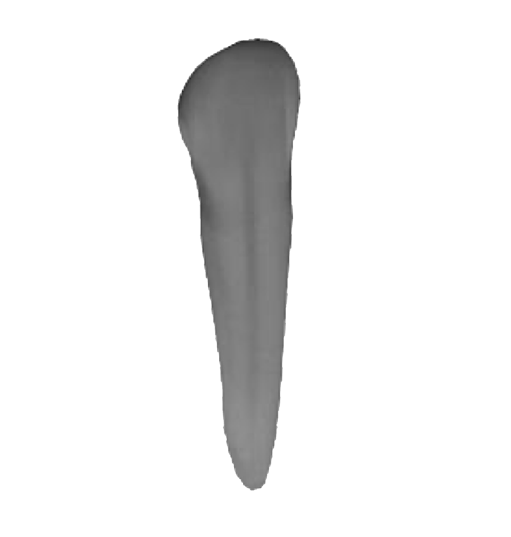
Figure 2. Outline of the pulp structure.